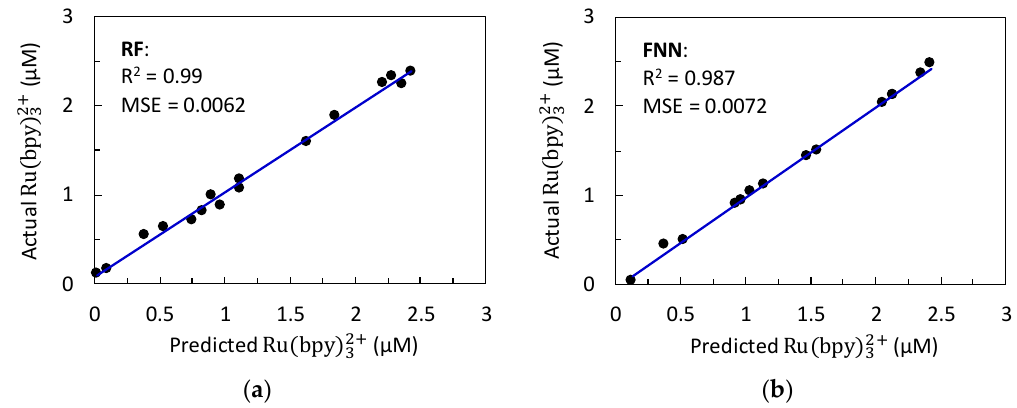
obtained for validation set 3 obtained for the testing set 3